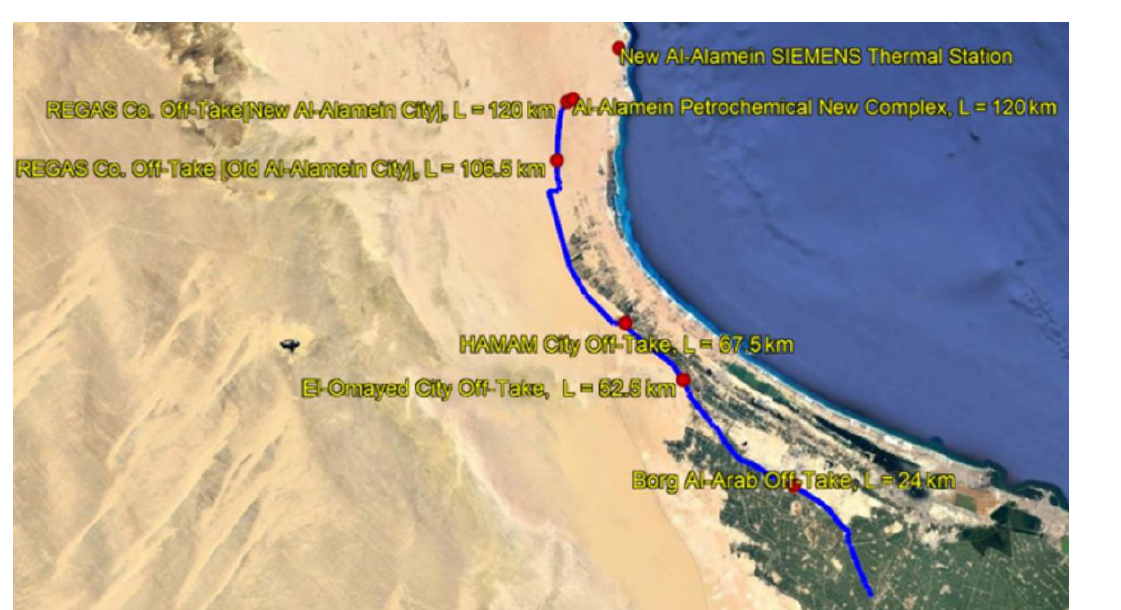
Figure 2. The New Al-Alamein city gas pipeline extension, in addition to the planned SIEMENS thermal power plant geographical location (a screenshot taken from Google